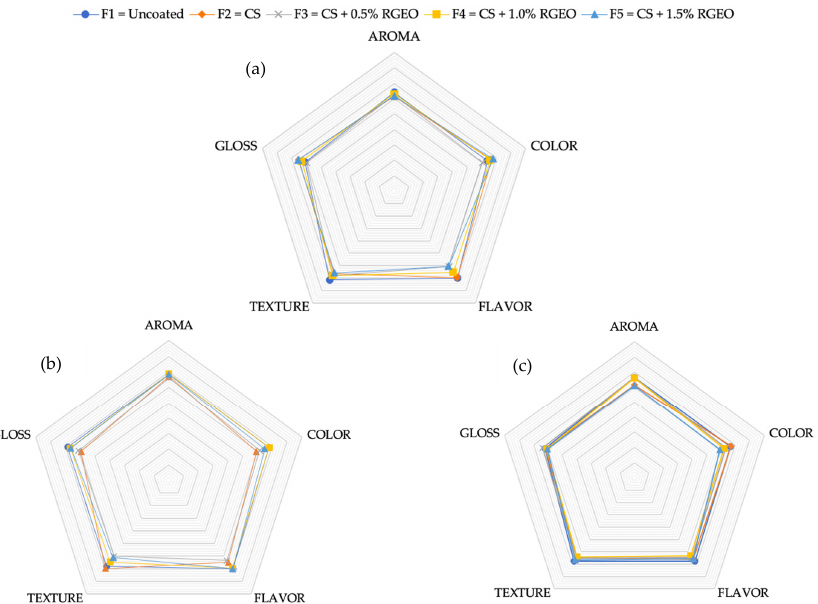
Figure 10. The hedonistic scale of guavas treated with the different formulations on day 0 ( a ), day 5 ( b ), and day 10 ( c). After treatment, sensory assessors presented significant differences between control and coated pears with F4 (CS + RGEO1.0%) and F5 (CS + RGEO1.5%) after day 5. On day